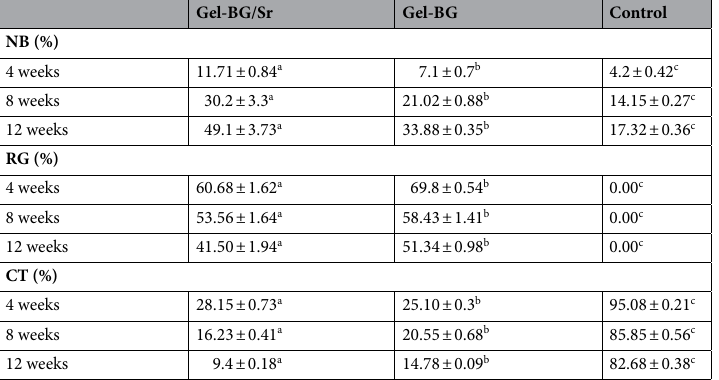
Table 1. Histomorphometric analysis of new bone, connective tissue and residual graft during 4, 8 and 12 weeks. Data are represented as mean ± SD. Different letters in each row show P < 0.001; a, b, c: significant difference with other groups at the same time; NB The percentage of New Bone, RG the percentage of Residual Graft, CT The percentage of Connective Tissue.